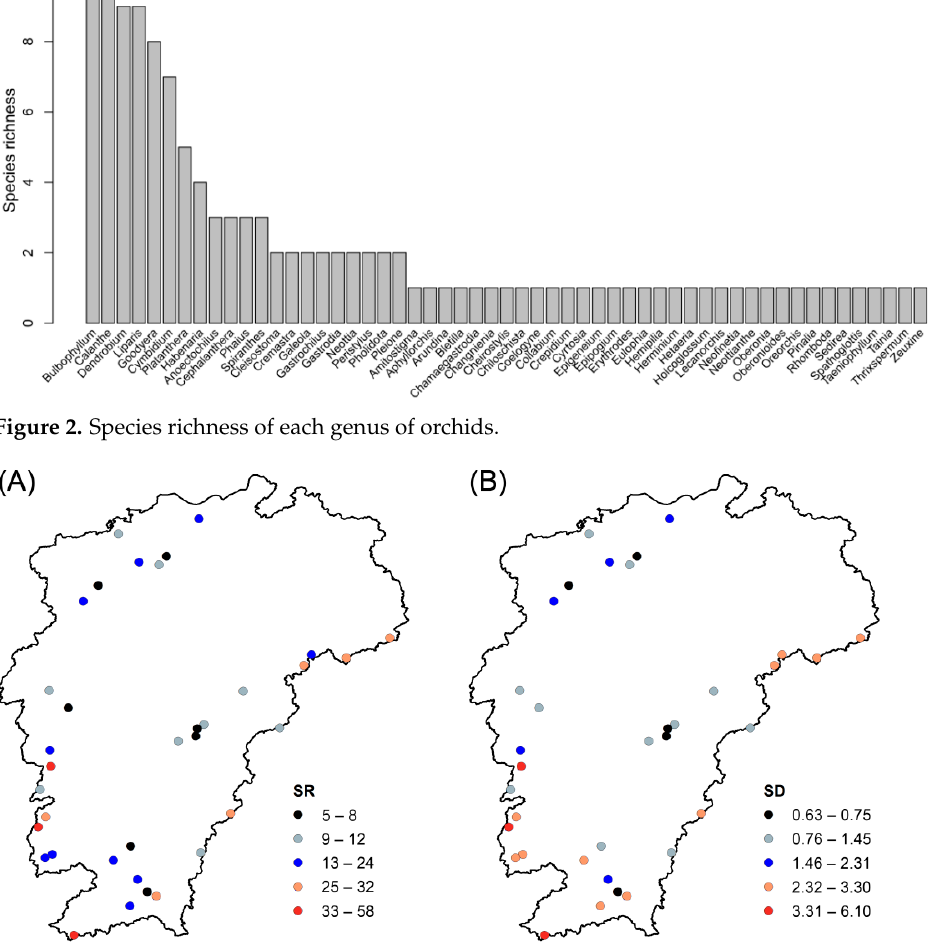
Figure 3. Geographic patterns of ( A ) species richness (SR) and ( B ) species density (SD) of orchids in 35 nature reserves of Jiangxi.